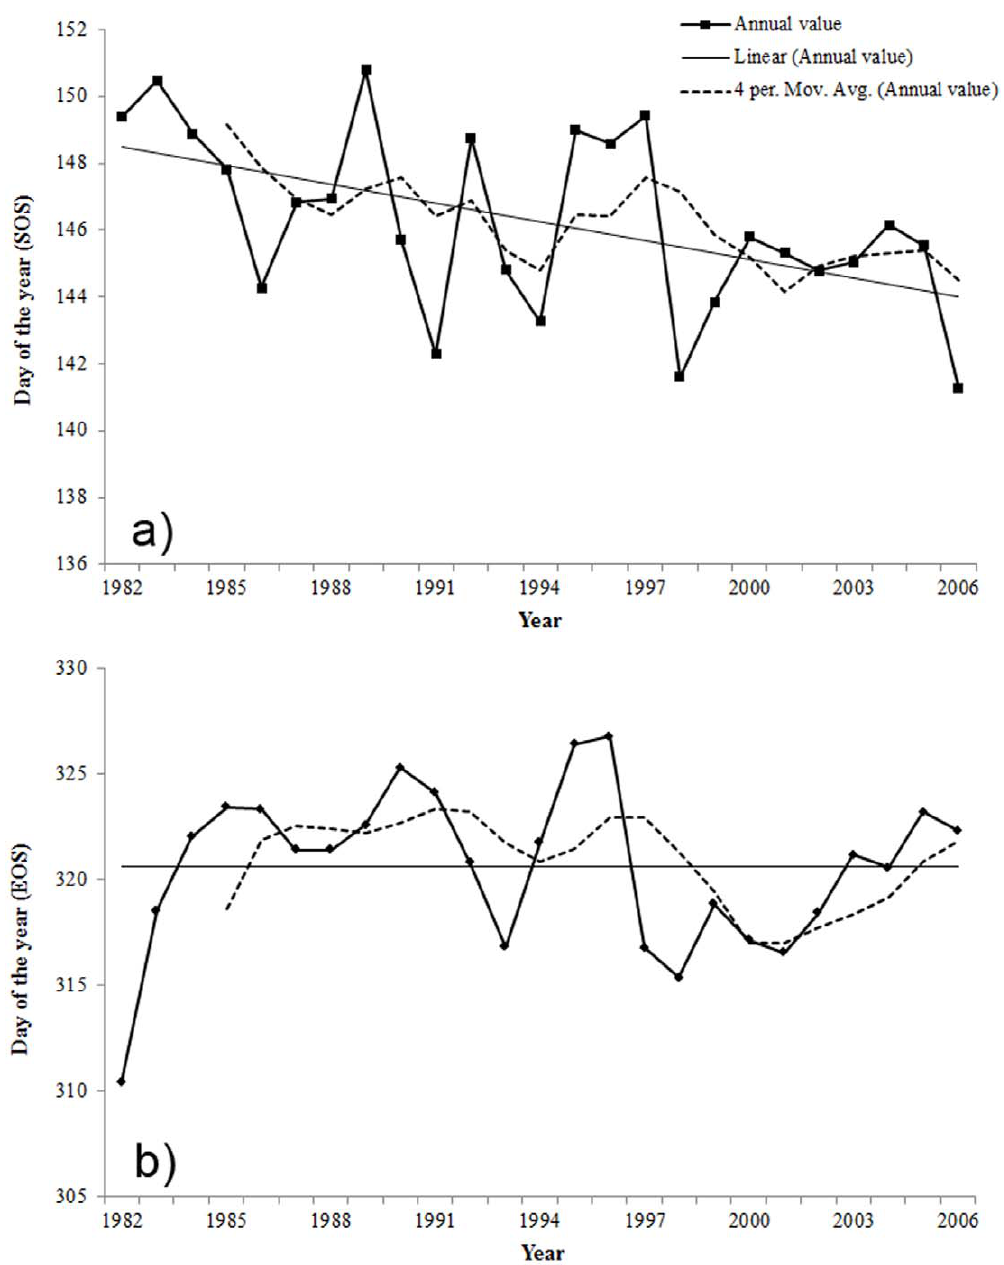
Figure 5. Annual variations and trends of spatially-averaged SOS and EOS in the Himalayas from 1982 – 2006.